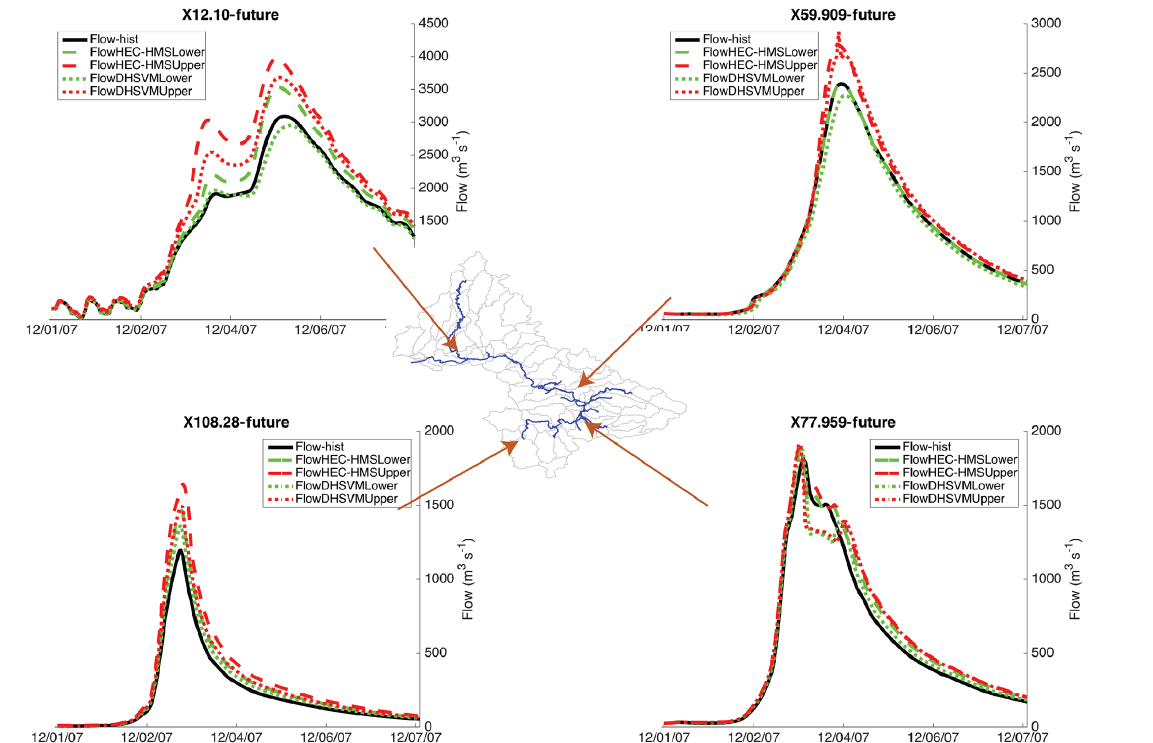
Figure 11. Streamflow hydrographs for observed (black) and simulated using HEC-HMS (dashed) and DHSVM (dotted) for the lower scenario (green) and higher scenario (red).